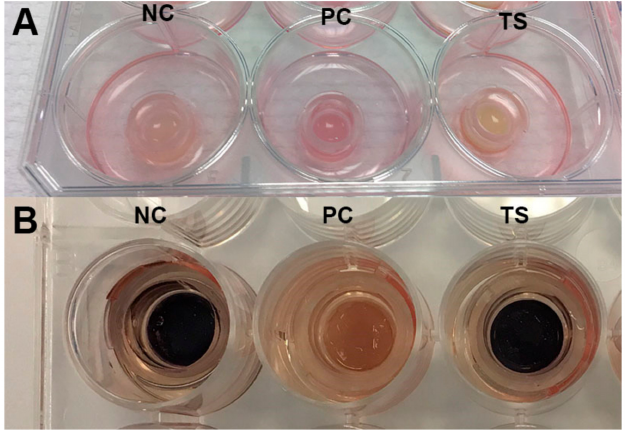
Figure 1. The view of 3D reconstructed human skin inserts during in vitro skin irritation evaluation before ( A ) and after ( B ) cell viability test after 18 h of incubation. NC—negative control (distilled water); PC—positive control (1% Triton X-100); TS—test sample (multiple